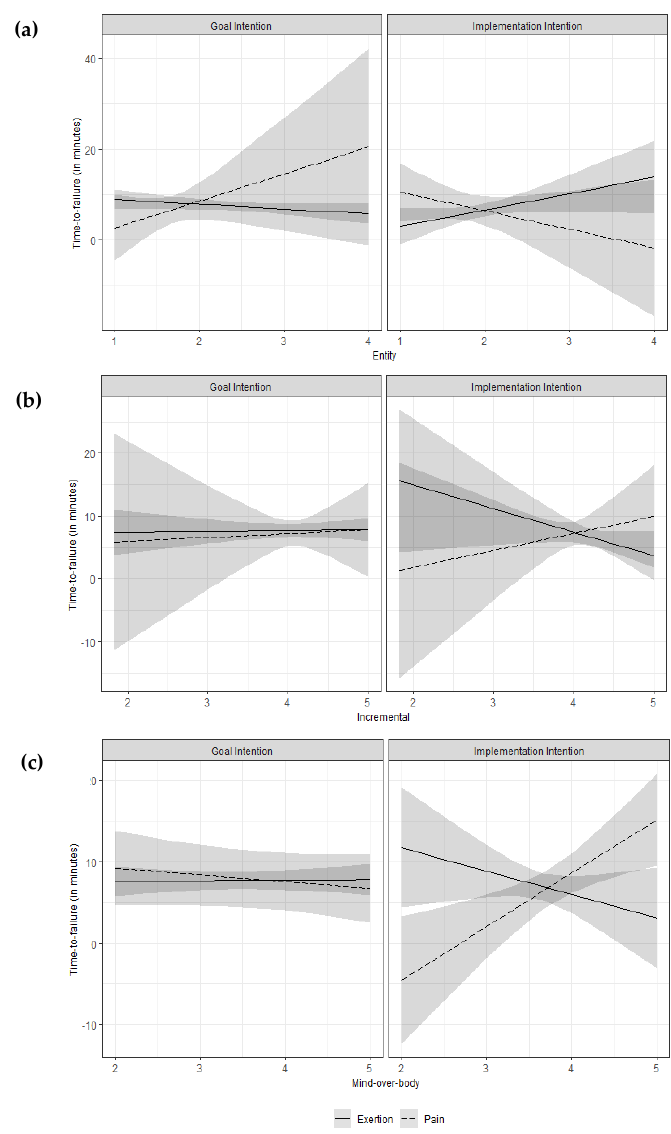
Figure 3. Estimated time-to-failure as a function of Condition (goal vs. if-then plan), Limit (reason for baseline task termination: exertion vs. pain) and ( a ) entity beliefs, ( b ) incremental beliefs and ( c ) mind-over-body beliefs. Higher values of entity beliefs represent a stronger belief that athletic ability is stable and fixed, while higher values of incremental beliefs represent a stronger belief that athletic ability is changeable by e ff ort and training. Finally, higher values of mind-over-body beliefs represent a stronger belief that the mind (i.e., mental factors) rather than then the body (i.e., physical factors) limits athletic